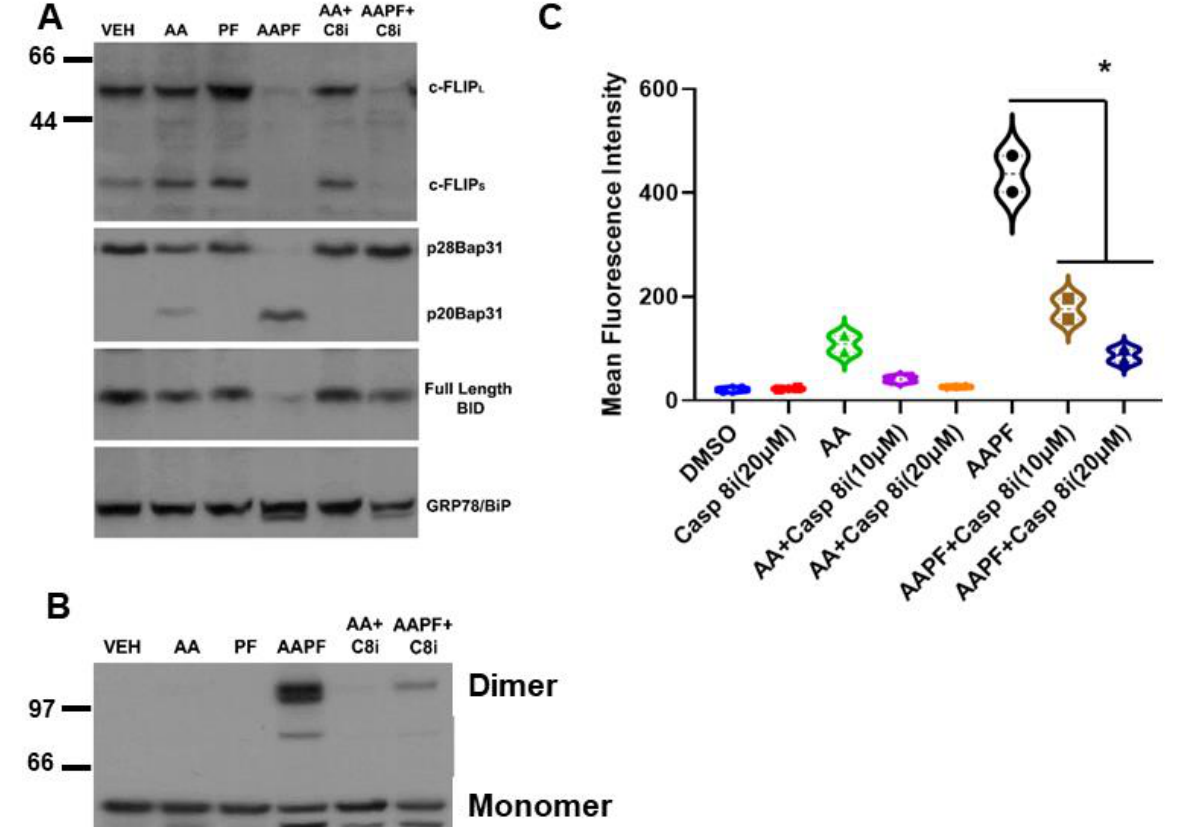
Figure 3. SphK inhibitors synergize with ABT/AZD to induce c-FLIP L/S depletion upstream of Caspase 8 activation. ( A ). DLD-1 cells were treated with ABT/AZD (AA; 0.5/0.25 µM, respectively) ± PF-543 (5 µM) for 16 h. AAPF induced depletion of c-FLIP L/S and induced activation of Caspase 8 as determined by cleavage of the Casp8 substrates Bap31 and BID. Inhibition of Casp8 (z-IETD-fmk; 10 µM) blocked Bap31 and BID cleavage but c-FLIP L/S depletion was independent of Casp8 activity suggesting that SphK generated S1P stabilizes c-FLIP under conditions of ER stress ( n = 3). ( B ). and monomeric forms of CRT are indicated). ( C ). Casp8 inhibition dose-dependently reduced ABT/AZD alone and significantly reduced ABT/AZD + PF-543 induced ectoCRT exposure. Statistical analysis was performed using one-way ANOVA followed by Tukey’s multiple comparison